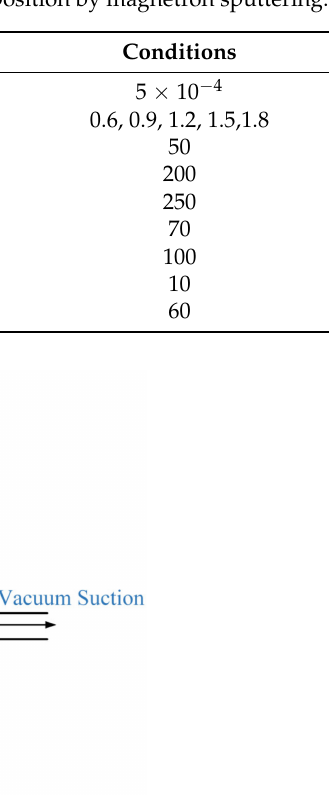
Figure 1. Schematic diagram of the deposition process of the Ce-Ti/MoS 2